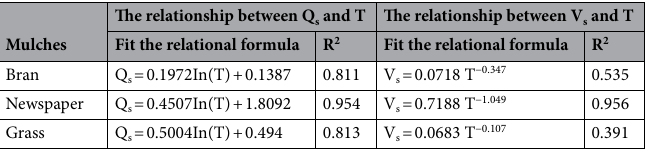
Table 3. Regression equations of water loss and water loss time for different organic